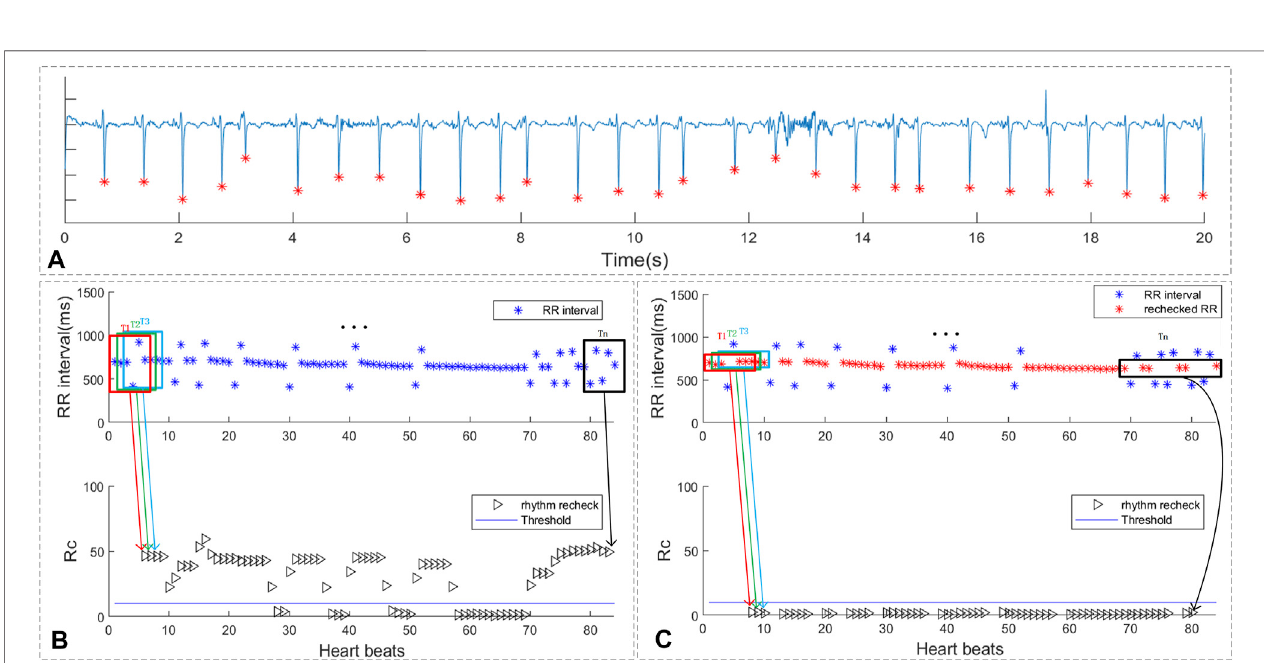
FIGURE 7 | The rhythm recheck result of ECG with multi premature beats. (A) ECG segment with multi PAC beats; (B) RR intervals and suspicious segment screening result. (C) the rechecked RR intervals and suspicious segment screening result